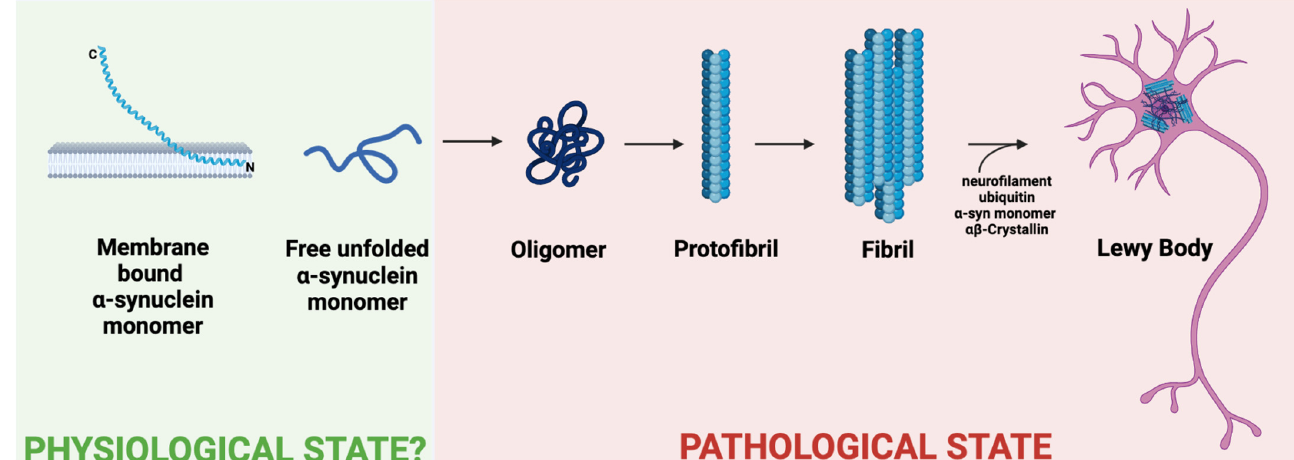
Figure 1. Progression of α -syn from potentially physiological to pathological states. Various mis- folded forms of α -syn exist in the pathological state, and whether membrane-bound α -syn is phys- iological remains controversial [51,52]. Membrane features influence membrane-bound forms of α -syn, allowing it to exist as a pair of anti-parallel curved α -helices or a single curved α -helix (as shown) [53]. Various forms of monomeric and fibrillar α -syn combine with neurofilaments, ubiquitin, and αβ -Crystallin to accumulate in neurons as Lewy bodies [54].